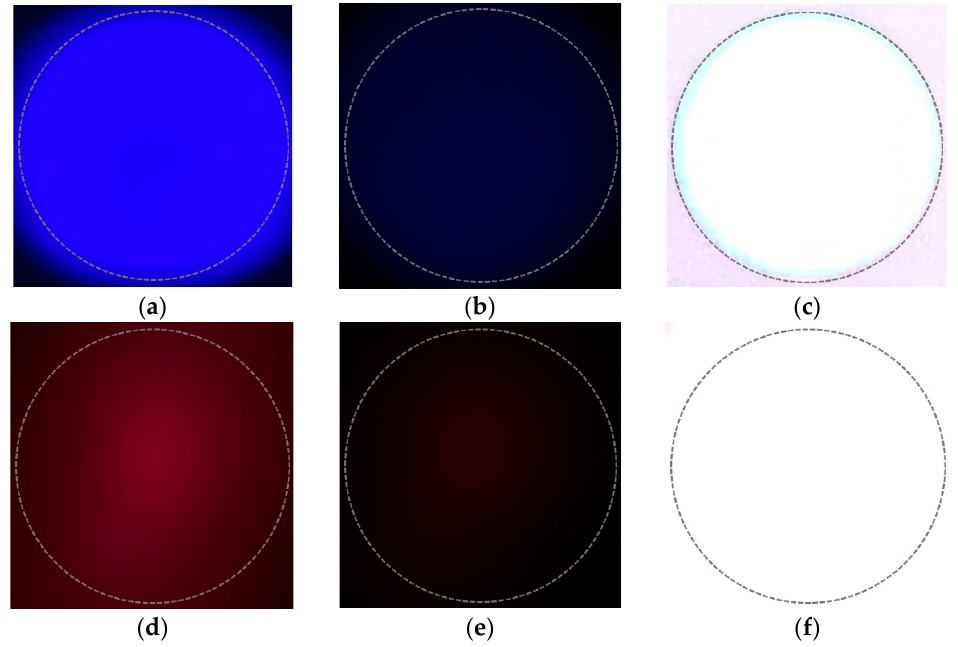
Figure 9. Differences in symbol images according to camera parameter adjustment. ( a ) When exposure is appropriate; ( b ) when exposure is low; ( c ) when exposure is high; ( d ) when exposure is appropriate; ( e ) when exposure is low; ( f ) when exposure is high.